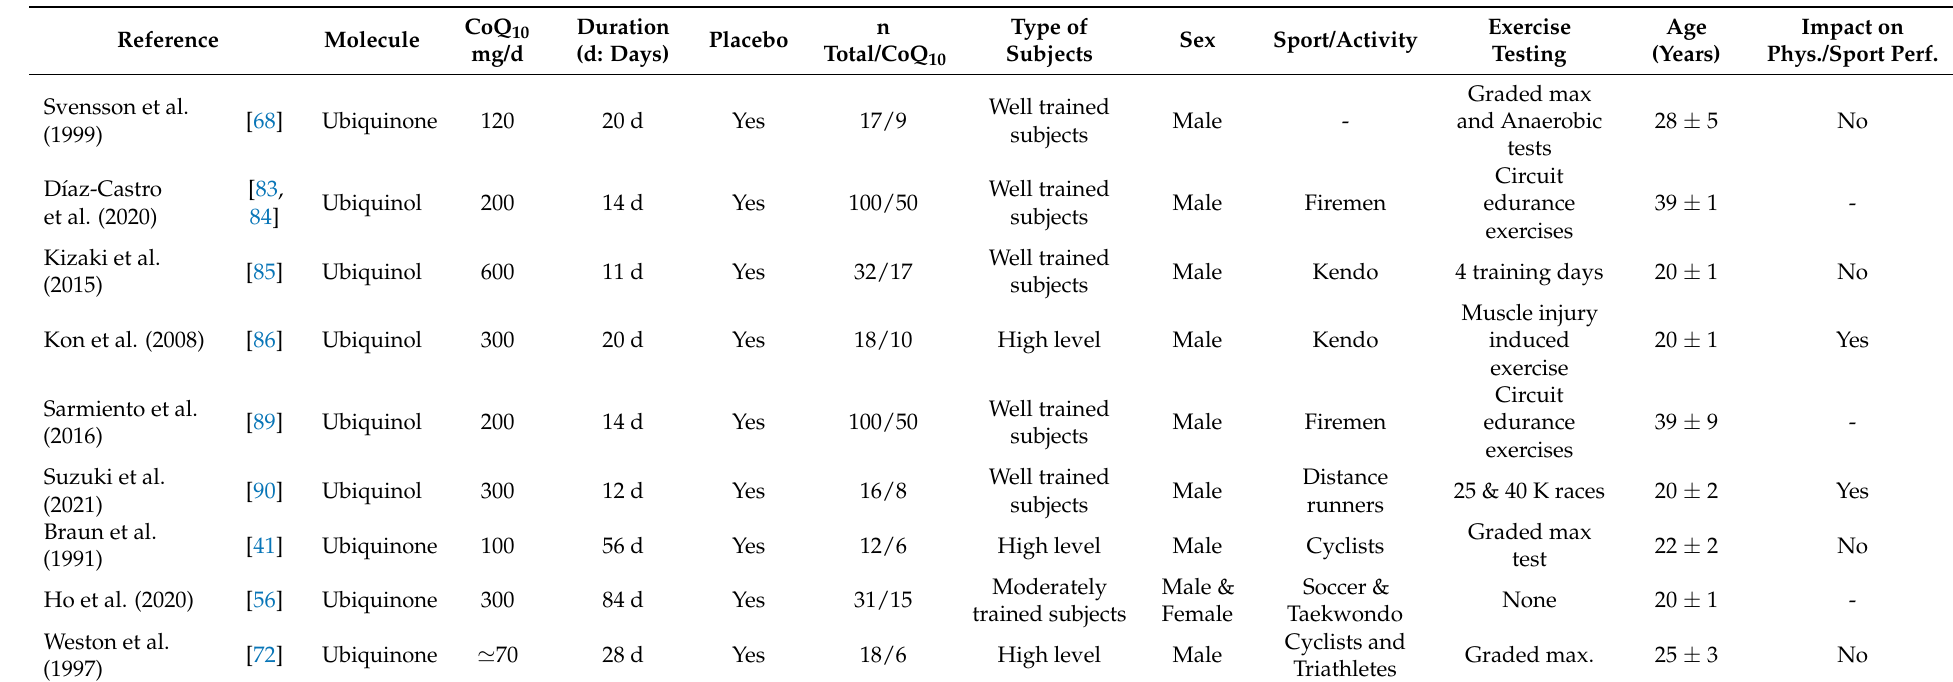
Table 2. Studies with the inclusion